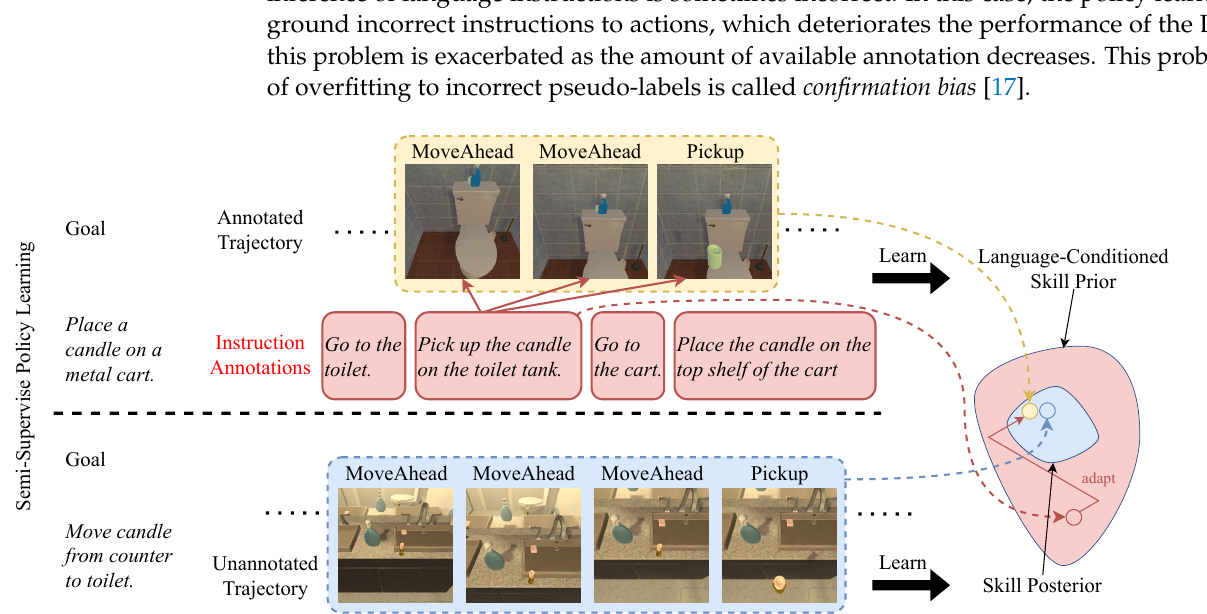
Figure 1. Semi-supervised LLP learning with sparse language